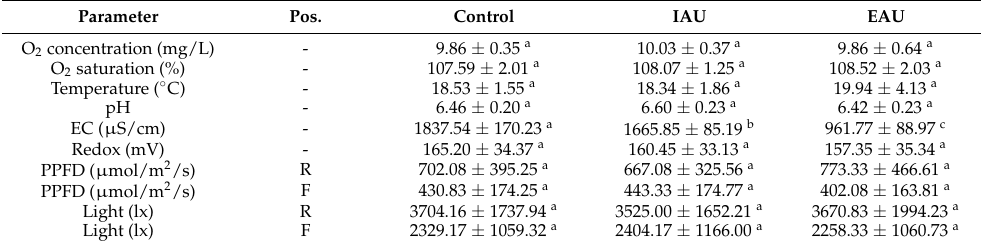
Table 3. Physical water quality parameters of nutrient tanks with water from fertilized tap water (Control) and fish effluents from intensive aquaculture unit (IAU) and extensive aquaculture unit (EAU); light condition parameters were measured in two positions (Pos.): “R”: rear table; “F”: front table (mean ± SD, n = 3). Parameter Pos.